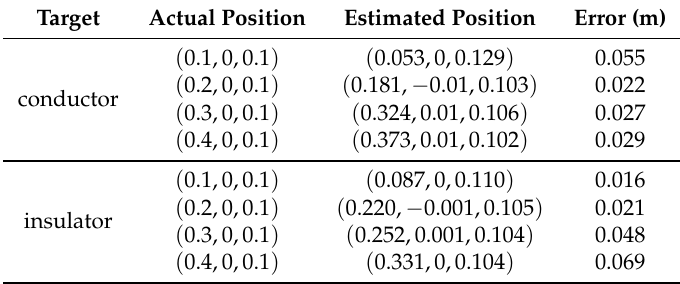
Table 5. The estimated positions of the conductor target and insulator target in different positions. Target Actual Position Estimated Position Error